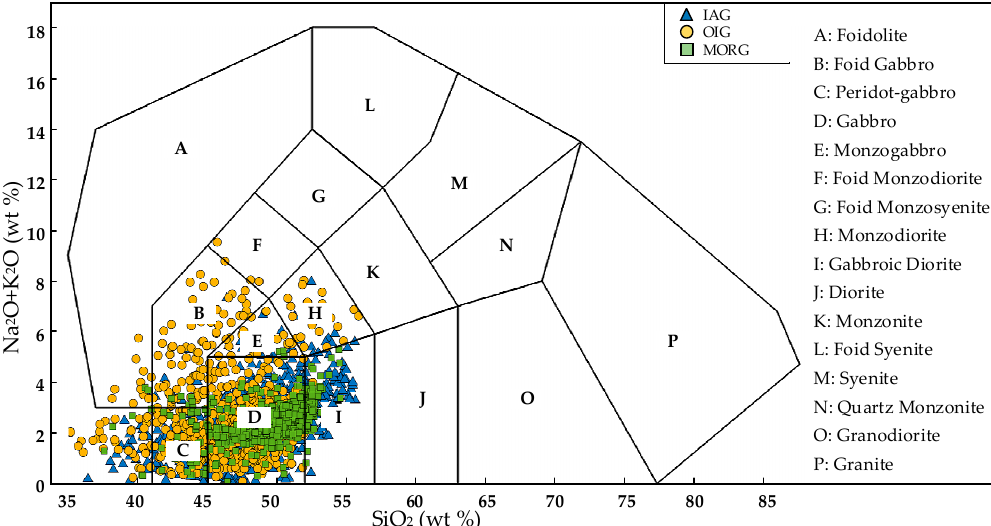
Figure 10. Plutonic TAS diagram (the boundaries are from Middlemost [31]).